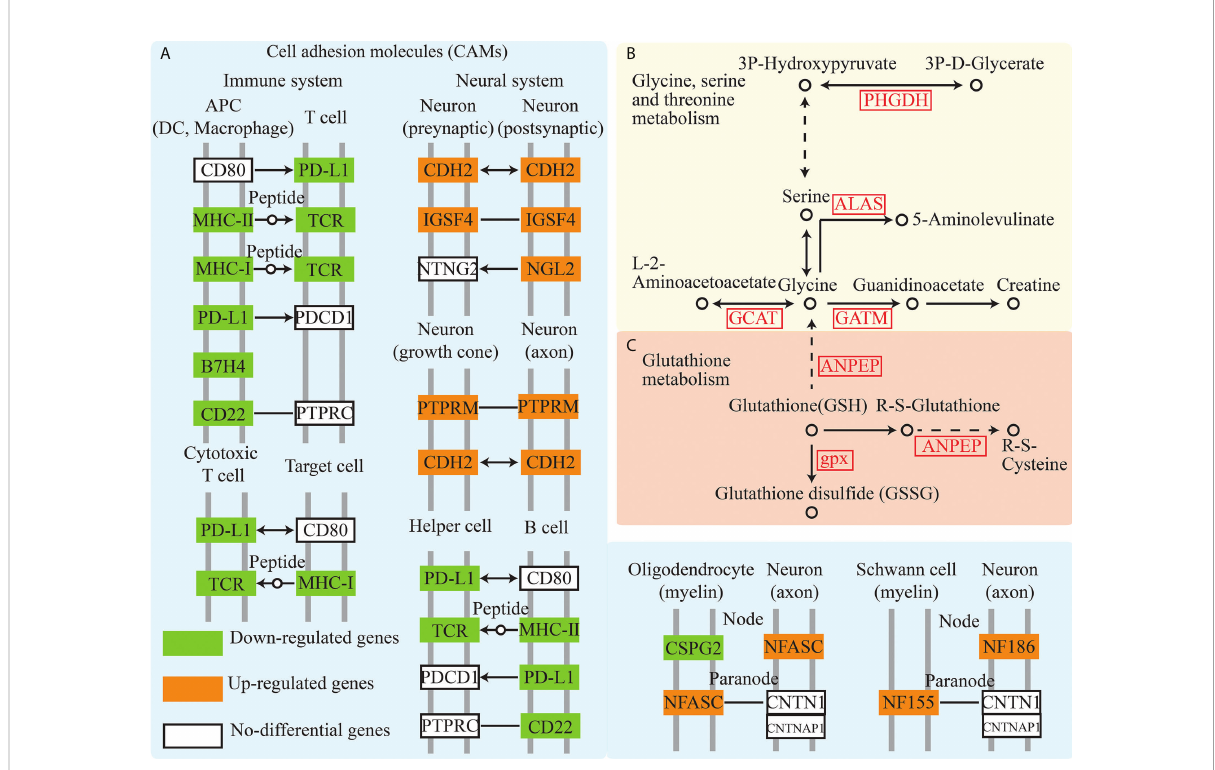
FIGURE 2 Cell adhesion molecules, glycine, serine and threonine metabolism, and glutathione metabolism pathway analysis from transcriptome. (A – C) showed the Cell adhesion molecules, glycine, serine and threonine metabolism, and Glutathione metabolism pathway,